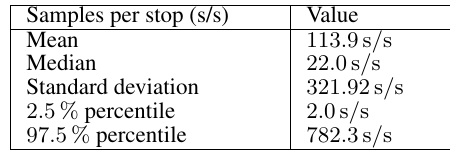
Table 2. Statistical details of the samples per stop.